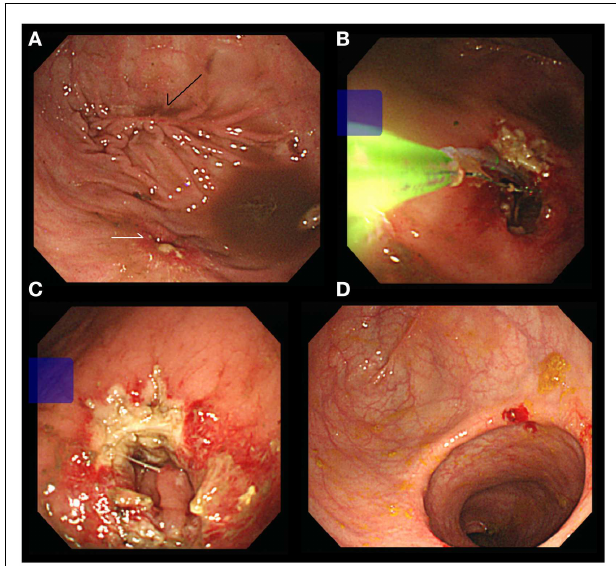
FIGURE 1 | (A) Stricture of anastomosis (white arrow). Note the previous stapled linear scar (black arrow). (B) Using Sphincterotomes to release the circumferential scar. (C) Complete the bilateral incisions. (D) Increased the diameter of anastomosis.